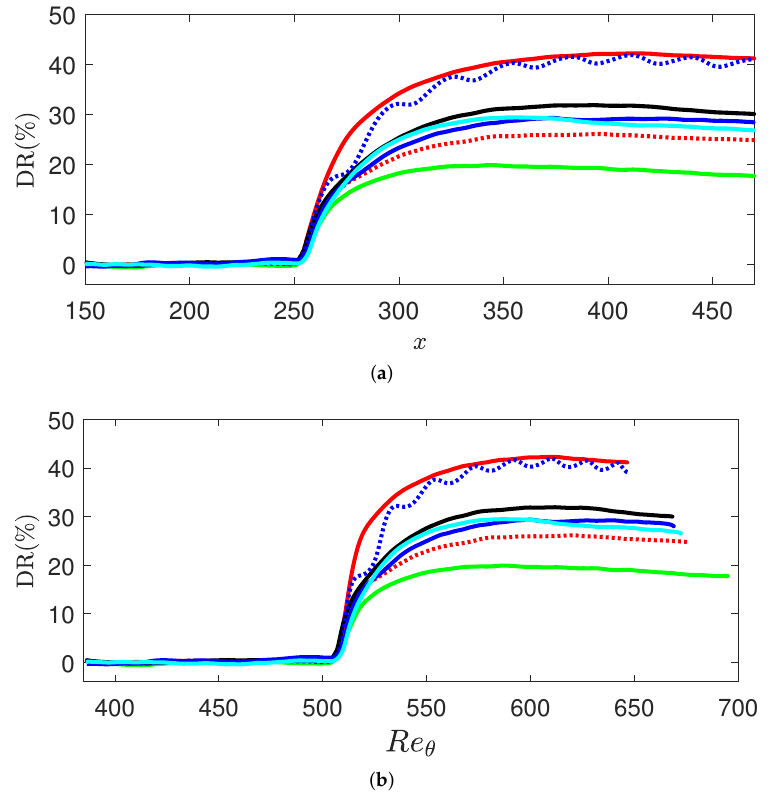
Figure 1. Drag reduction (DR) for the travelling wave forcing (red); temporal forcing cases with T + = 176 (red, broken); T + = 30 (green); T + = 100 (black); T + = 67 (cyan); T + = 132 (blue); and spatial forcing with λ + x = 1320 (broken blue). All cases with W + m = 12 except the cyan line ( W + m = 11.3). ( a ) DR versus downstream location ( x ). ( b ) DR versus Reynolds number ( Re θ ).